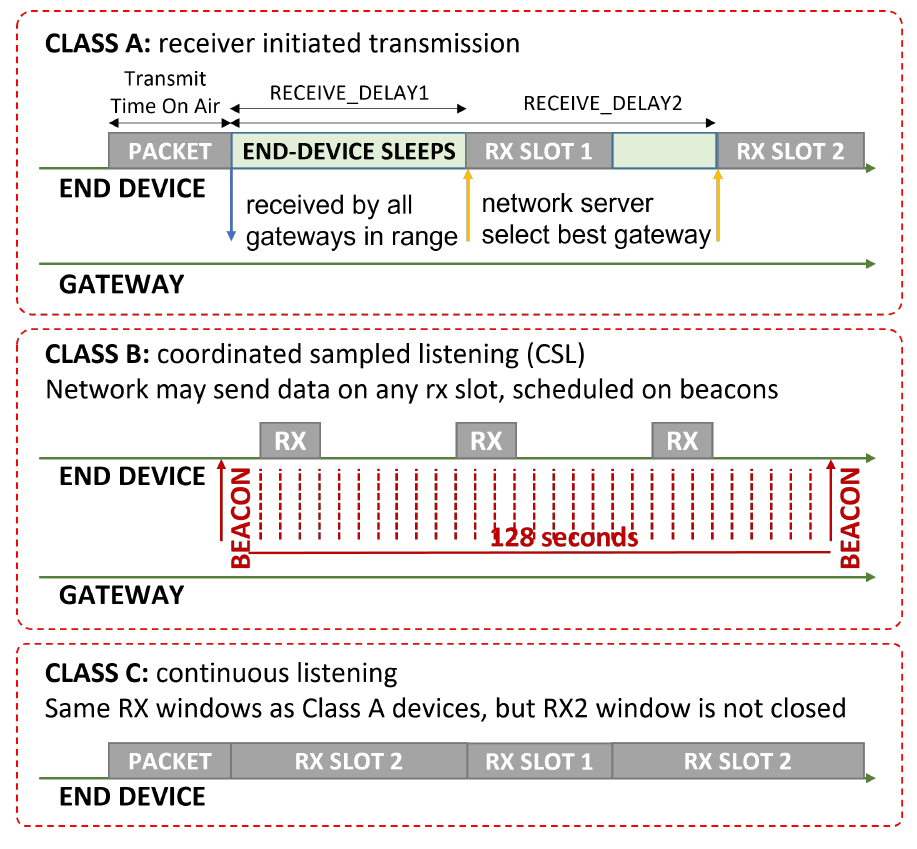
Figure 2. LoRaWAN device